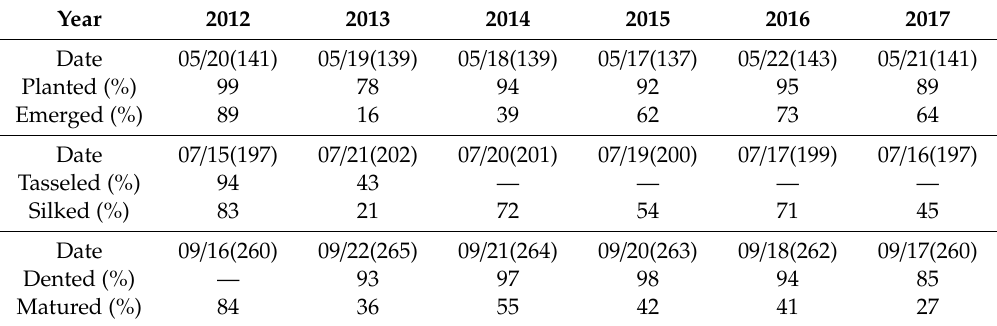
Table 3. Corn growth monitoring results in the west central district of Iowa released by NASS in different years from 2011 to 2017. In the “Date” rows, the numbers in the parentheses are Julian date corresponding to the calendar (Gregorian) date.